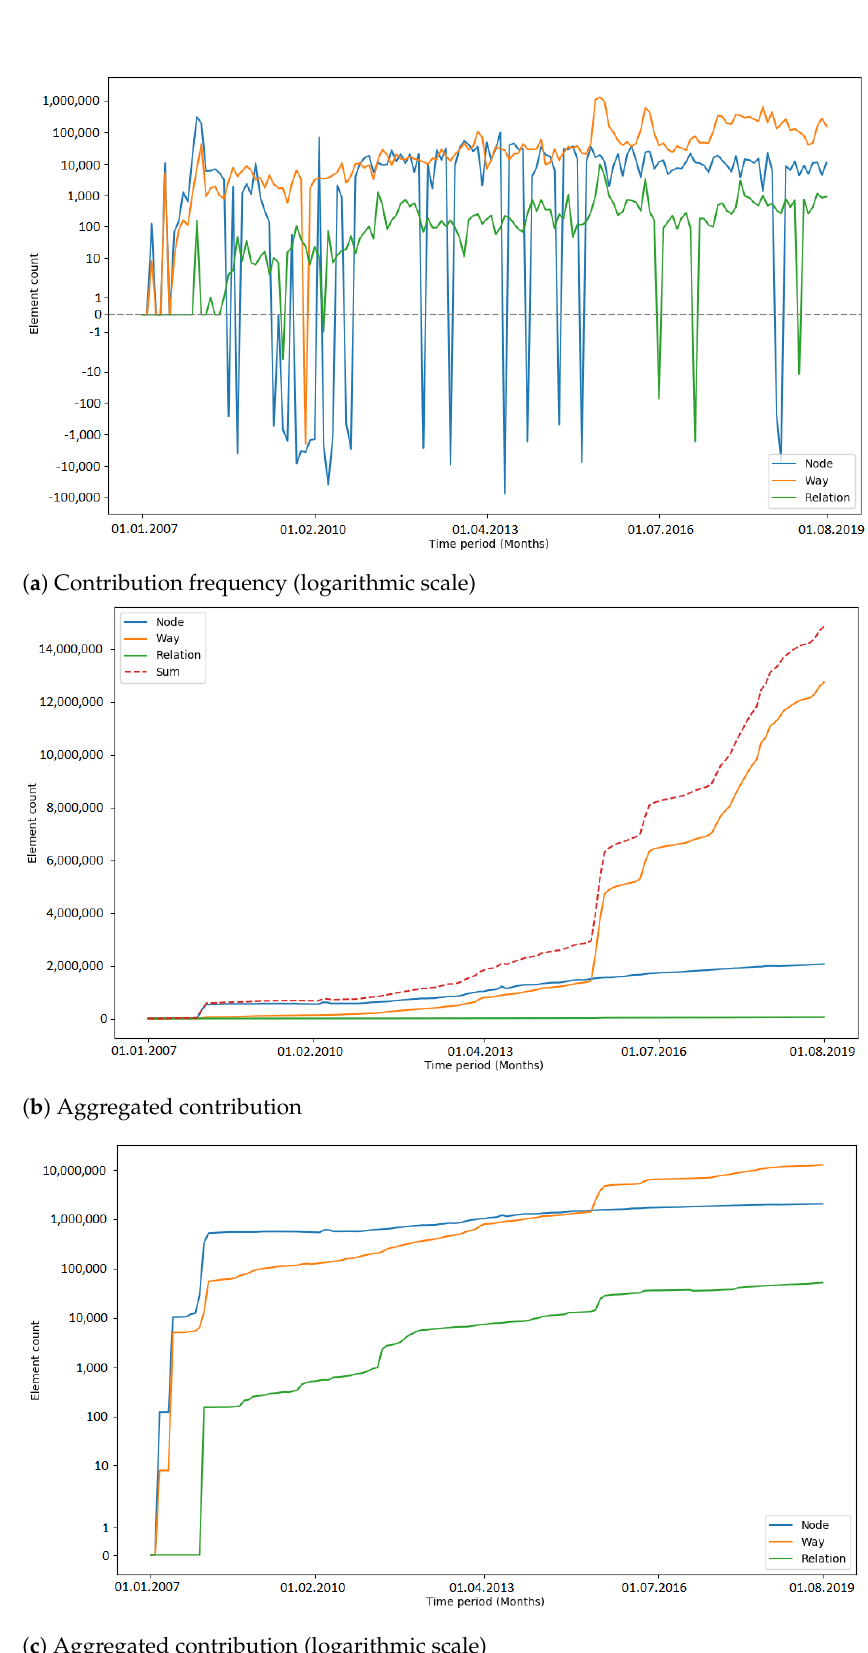
Figure 2. Contributions in